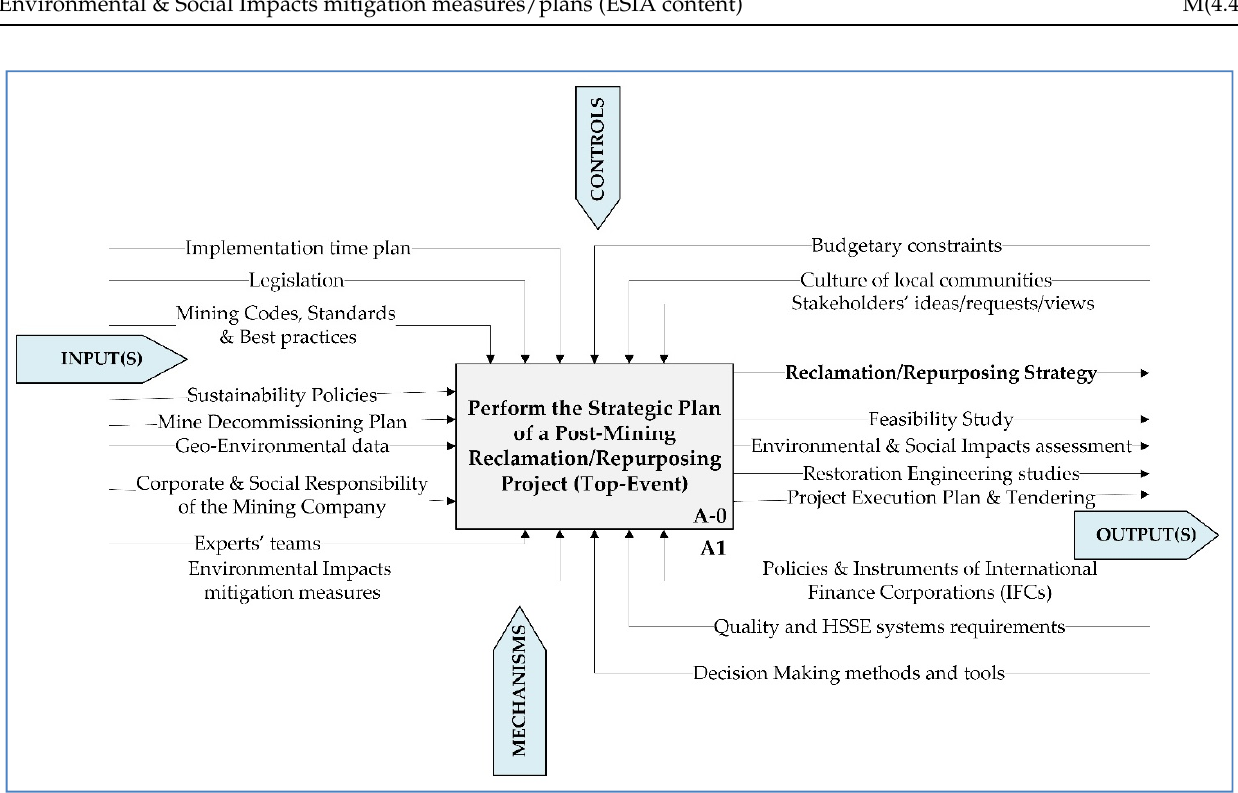
Figure 1. The A-0 concept diagram “Post-Mining Restoration/Repurposing Strategic